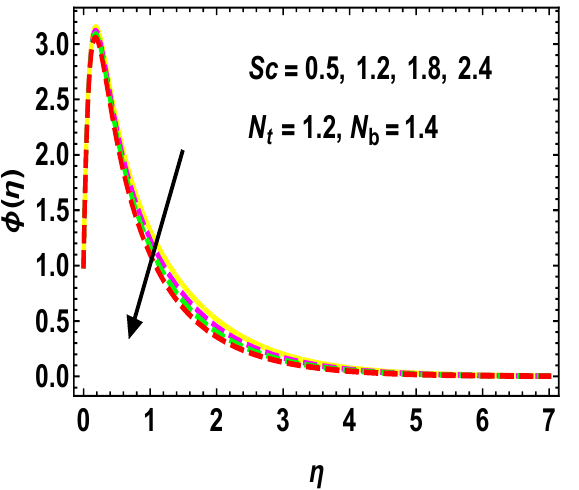
Figure 17. Outcomes of φ ( η ) for Sc where yellow, magenta, green, and red lines represent for Sc = 0.5, Sc = 1.2, Sc = 1.8, and Sc = 2.4 respectively.